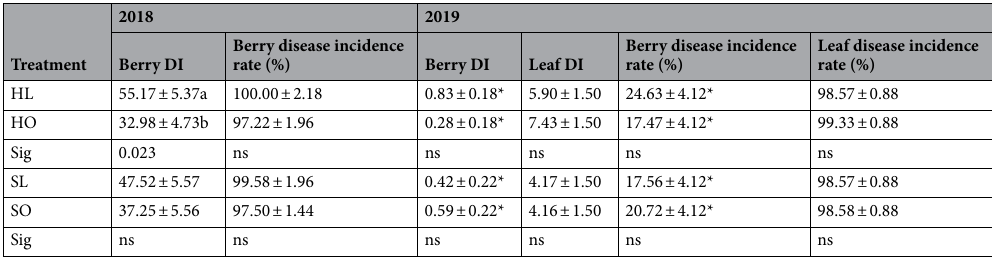
Table 6. Effect of lateral removal on the disease index and disease incidence rate of berries and leaves. Significant differences between treatments ( p < 0.05) are designated by different letters. Significant differences between years ( p < 0.05) are designated by